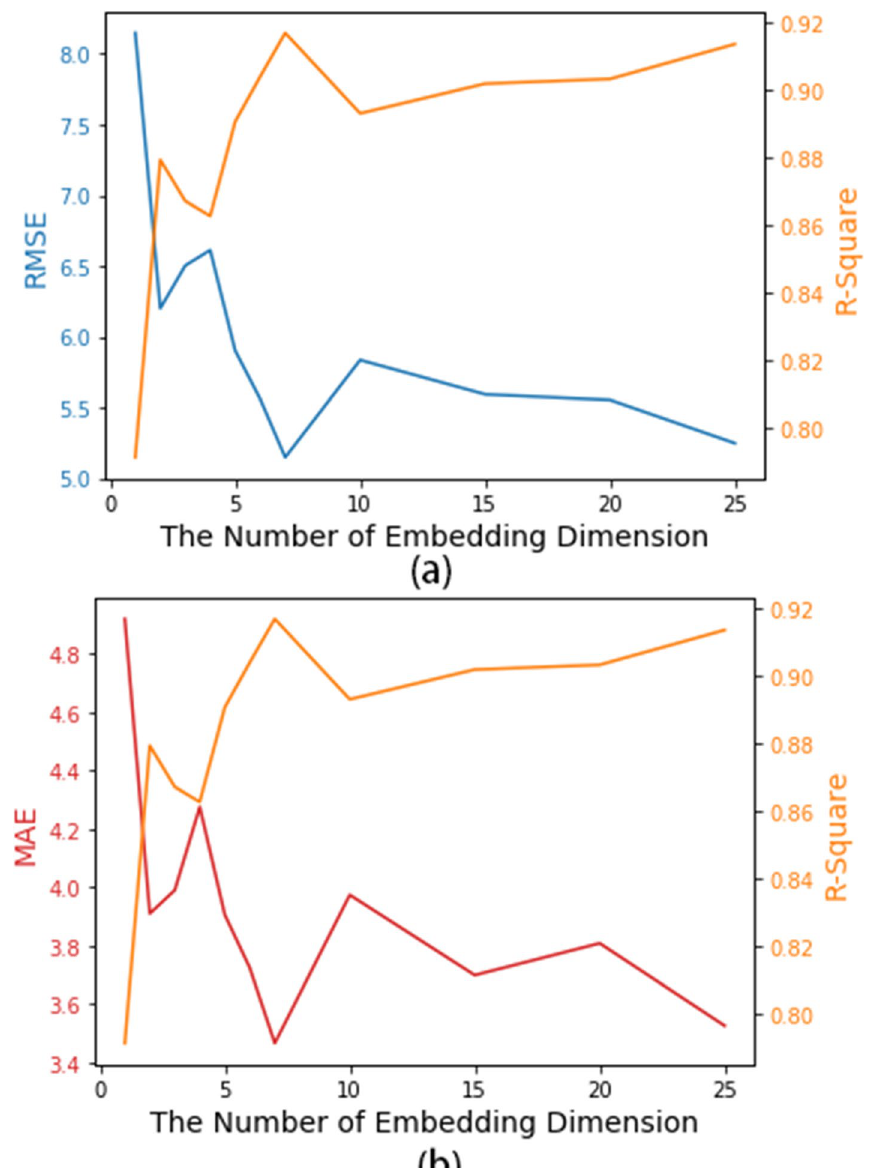
Fig. 5 The relationship between the prediction result and the embedding dimension of the multivariate time series feature matrix of the WT-ARIMA-XGBoost